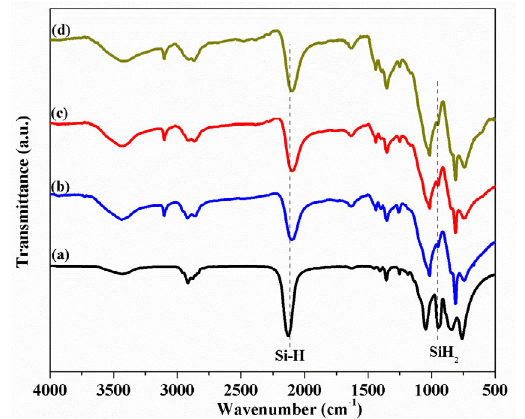
Fig. 3 FT-IR spectra of ABZ-1 treated at different temperatures in